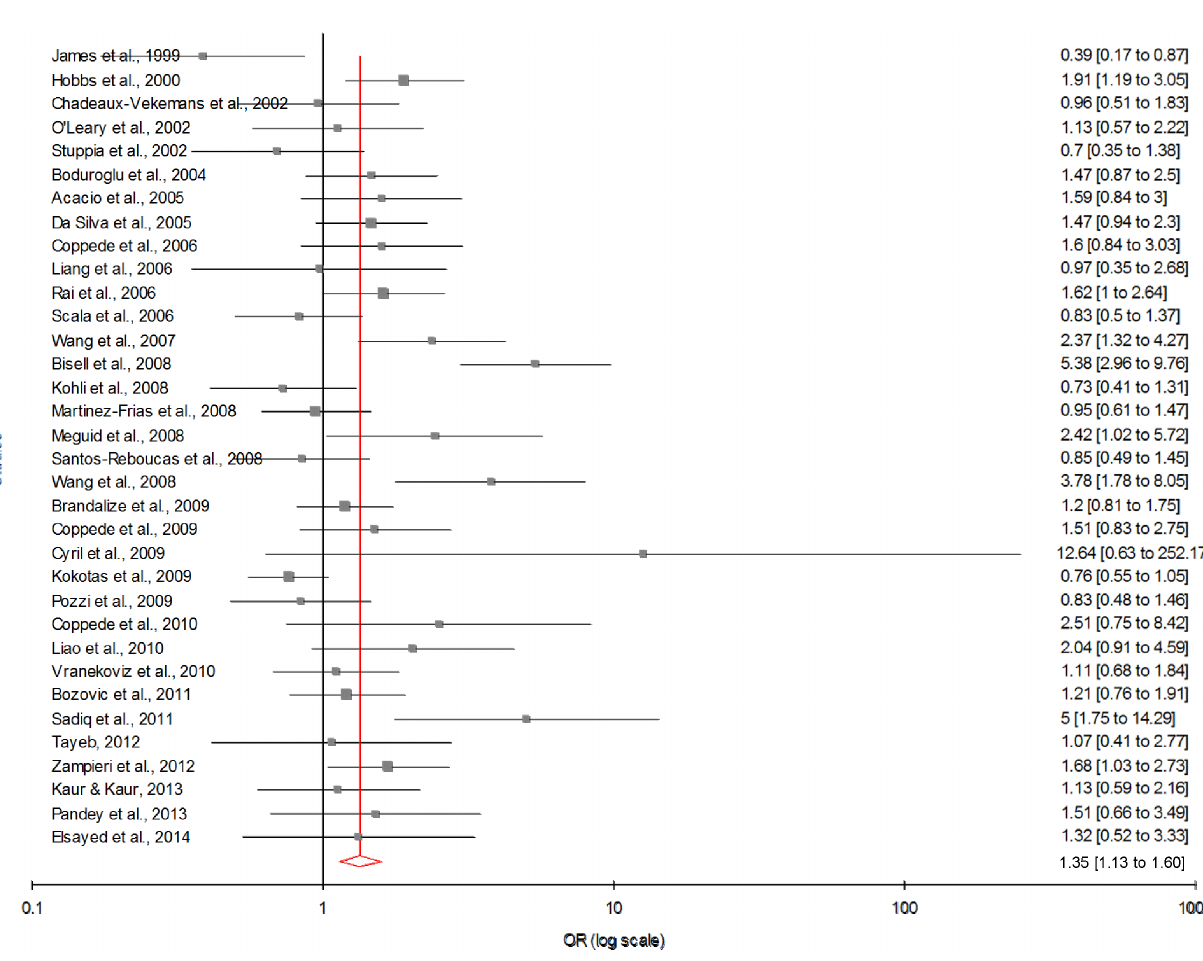
models with moderate statistical heterogeneity between-study (Figure 3). Association of mutant heterozygous genotype (CT vs. CC) was observed significant with fixed (OR CTvs.CC =1.23; 95%